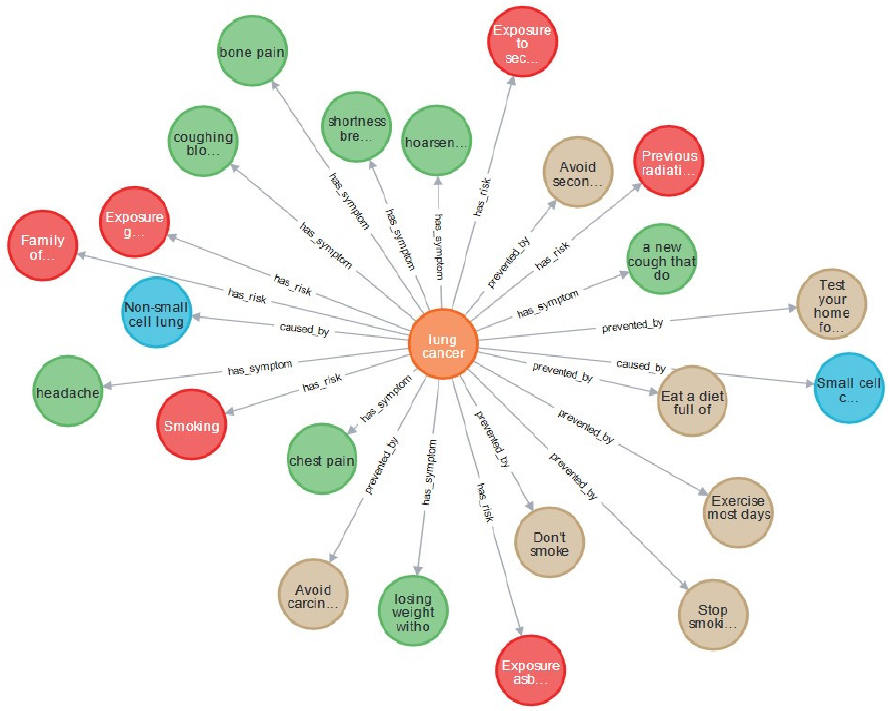
Figure 4. A subgraph of lung cancer disease node with all its four relationships with other